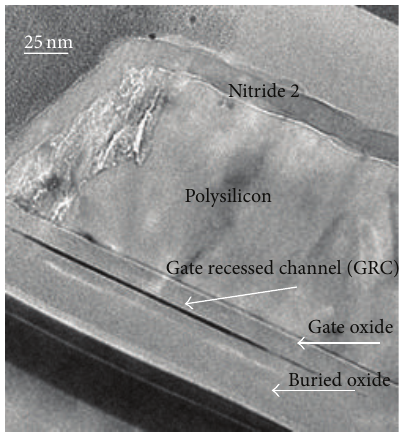
Figure 2: HRTEM image of a gate recessed channel (GRC) device, showing a view of the gate edge region. The silicon GRC film is 2.2 nm thick, while the gate oxide and the buried oxide films are, respectively, 26 nm and 70 nm